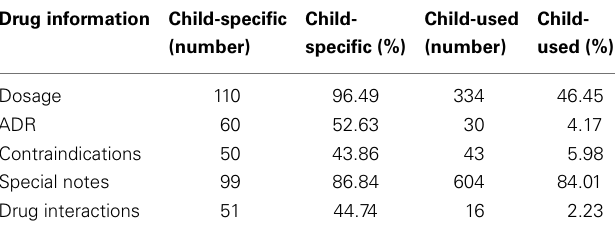
Table 5 | Pediatric label information integrity of non-prescription medicine